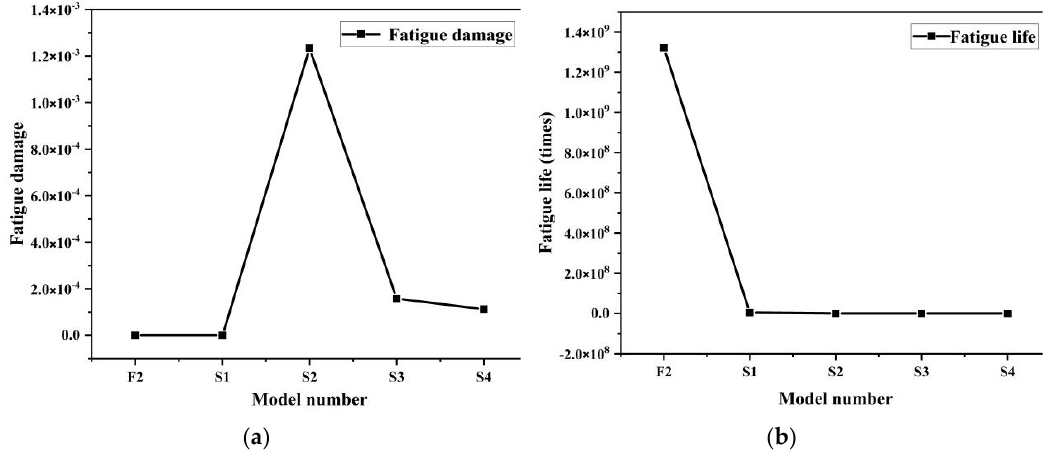
Figure 16. ( a ) Fatigue damage and ( b ) fatigue life of five